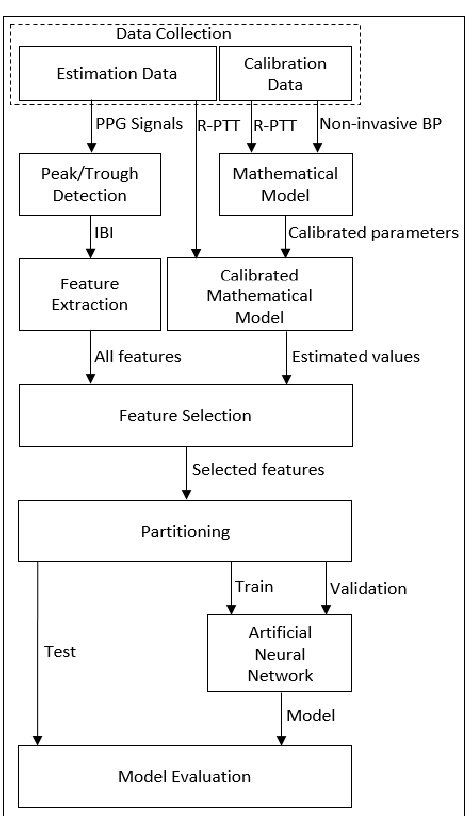
Figure 1. Block diagram of the method proposed in this paper for cuffless blood pressure estimation.